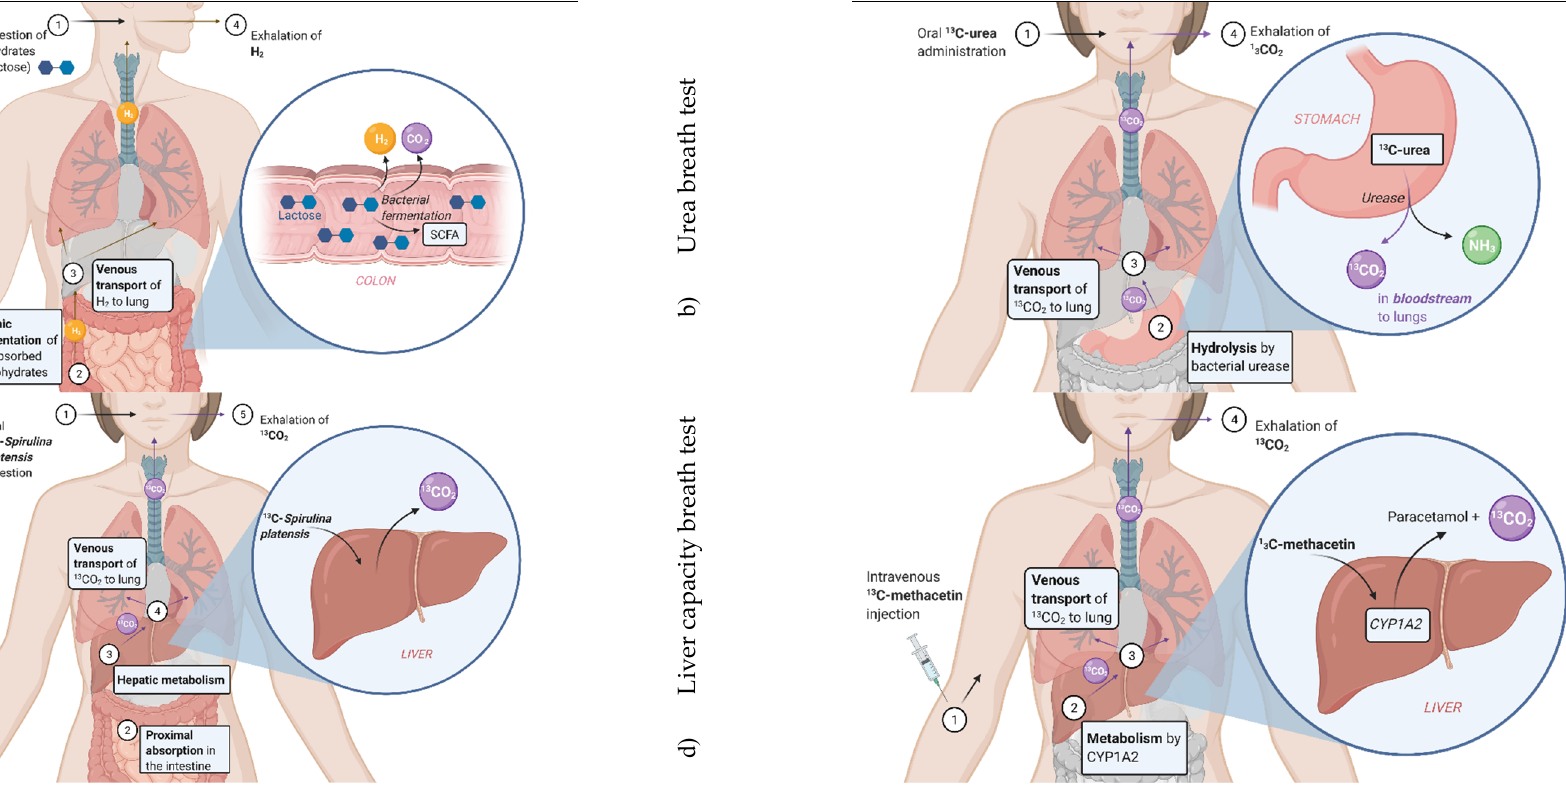
Figure 5. ( a ) Assessment of hypolactasia via the hydrogen breath test (HBT): colonic fermentation of ingested lactose after malabsorption leads to the production of molecular hydrogen (H 2 ), carbon dioxide (CO 2 ) and short-chain fatty acids (SCFA): the detection of H 2 in exhaled breath is possible after its venous transport to the lungs; ( b ) Diagnosis of H. pylori infection via the 13 C-urea breath test (UBT): orally ingested 13 C-urea is metabolised by urease enzyme to form 13 CO 2 (and ammonia, NH 3 ) in the stomach, which is transported to the lungs and can be detected in exhaled breath; ( c ) Stable isotope breath test for assessing solid gastric emptying using 13 C- S. platensis : the ingested substrate is absorbed in the small intestine and metabolised to 13 CO 2 in the liver, which is transported to the lungs and can be detected in exhaled breath; ( d ) Assessing liver function capacity after intravenous injection of 13 C-methacetin by continuous measurement of 13 CO 2 / 12 CO 2 -ratio: metabolism of the substrate in the liver by CYP1A2 enzymes forms 13 CO 2 , which can be detected in exhaled breath. Figures created with BioRender.com.